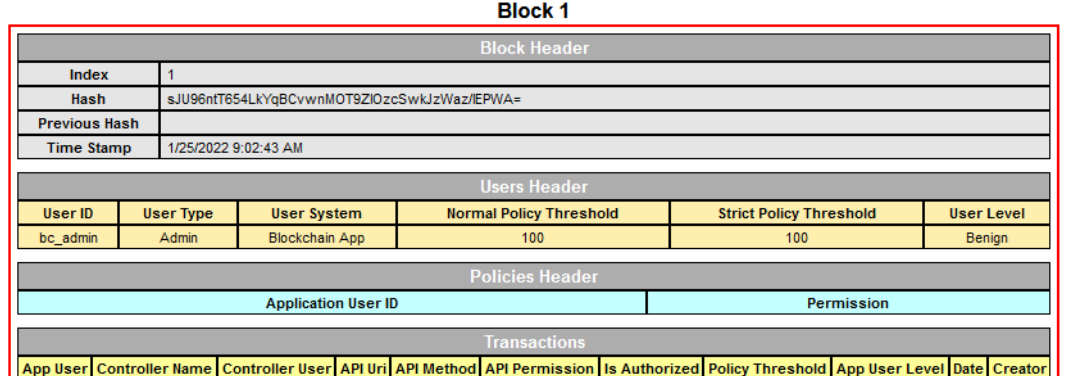
Figure 6. Block structure example.